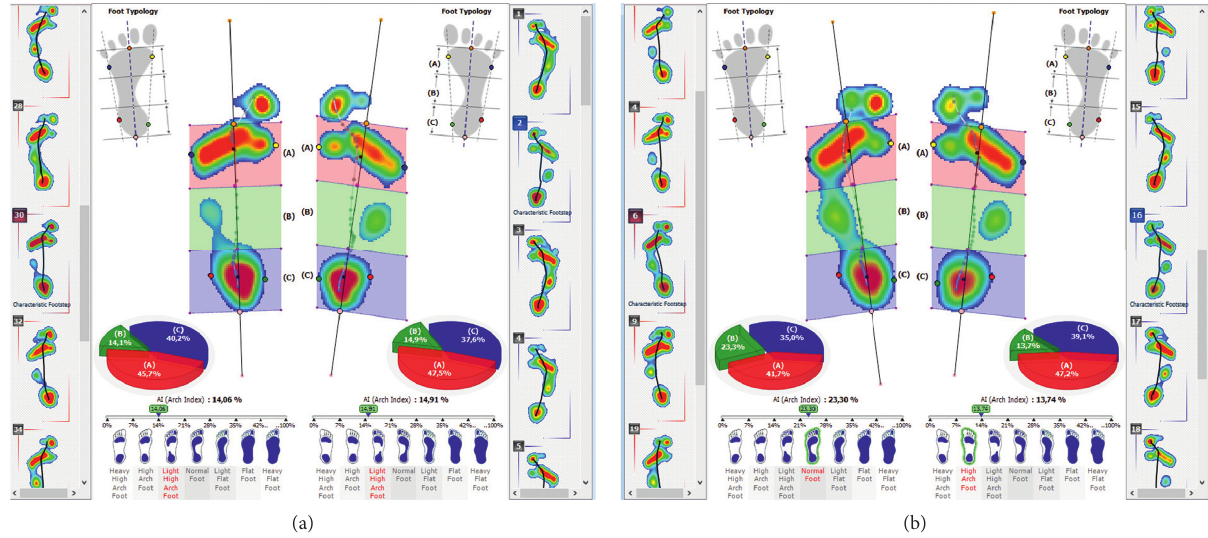
Figure 10: The exemplary result of the foot arch examination (AI index) (a) before and (b) after a therapeutic session (the examination is performed while walking).